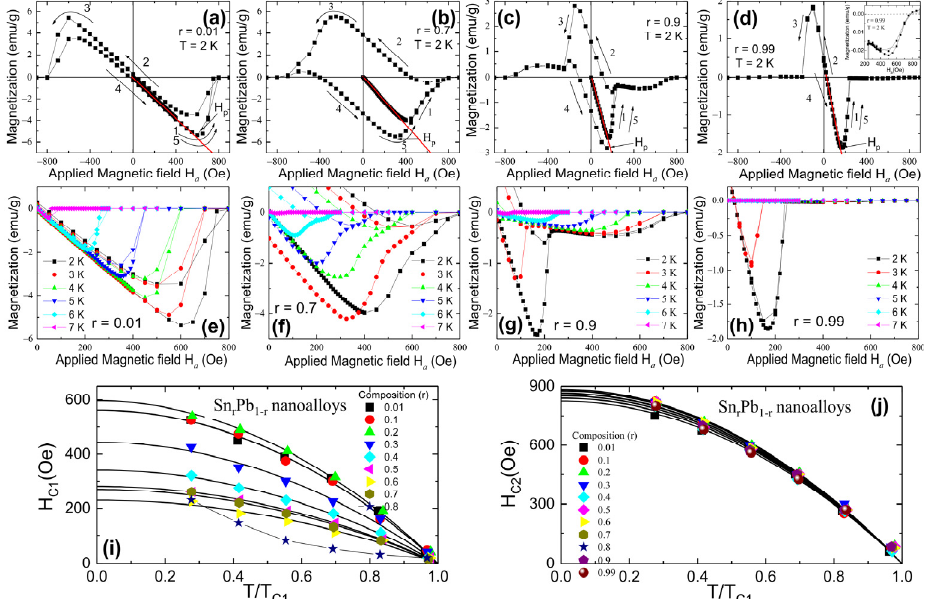
Figure 5. ( a – d ) isothermal magnetization M(H a ) loops measured at 2 K for r = 0.01, 0.7, 0.9 and 0.99 nanoalloys. The solid red line is the linear fit to the first magnetization curve. Arrows mark the observed irreversible field; ( e – h ) the M(H a ) loops measured using a protocol of H a = 0 Oe → +900 Oe → 0 Oe at higher temperature up to 7 K for r = 0.01, 0.7, 0.9, and 0.99 nanoalloys; ( i , j ) lower and upper critical field as a function of temperature. Solid lines fit the power law mentioned in the text.